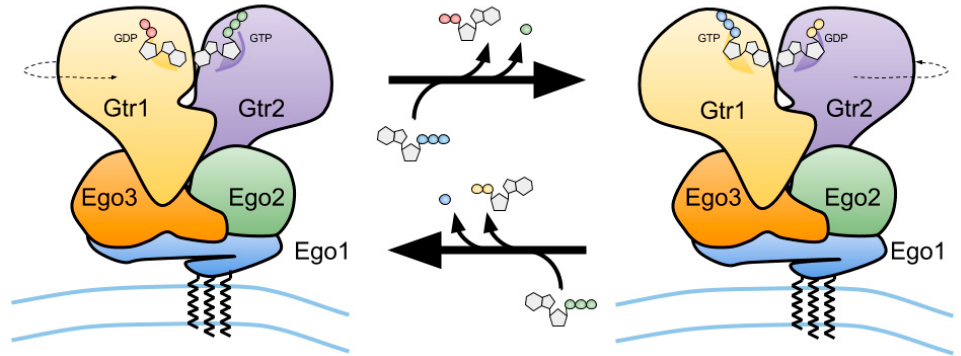
Figure 3. Schematic representation of the vacuolar membrane-bound budding yeast Ego1–Ego2–Ego3 ternary complex (EGO-TC), and of the conformational change of the EGO-TC-associated Gtr1–Gtr2 heterodimer following the exchange of GDP for GTP on Gtr1 and GTP hydrolysis by Gtr2 (upper arrow) and vice versa (lower arrow).